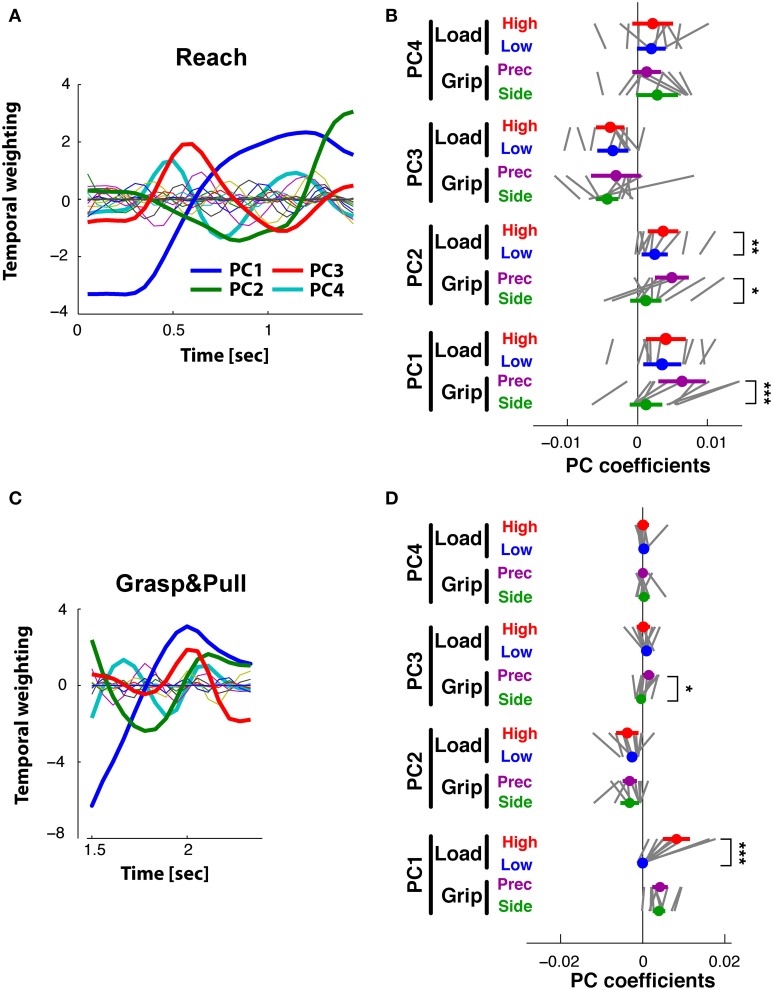
Reach period compared to grasp&pull period: PCA on time-varying EMGs. (A,B)
Reach period. (C,D)
Grasp&pull period. (A)
Reach: temporal weighting for the first four PCs (thick lines) and the other PCs. (B)
Reach: Average PC coefficients (colored dot) and ±95% confidence interval (colored horizontal bar) for each PC and task condition (thin black lines correspond to the average coefficients for each subject). Significant difference in average PC coefficients on PC1 and PC2 for GRIP, and on PC2 for low vs. high LOAD. (C)
Grasp&pull: temporal weighting for the first four PCs (thick lines) and the other PCs. (D)
Grasp&pull (scheme as in B): significant difference in average PC coefficients on PC1 for LOAD, and on PC3 for GRIP. *, **, *** Indicate significant difference at p < 0.05, p < 0.01 and p < 0.001, respectively.